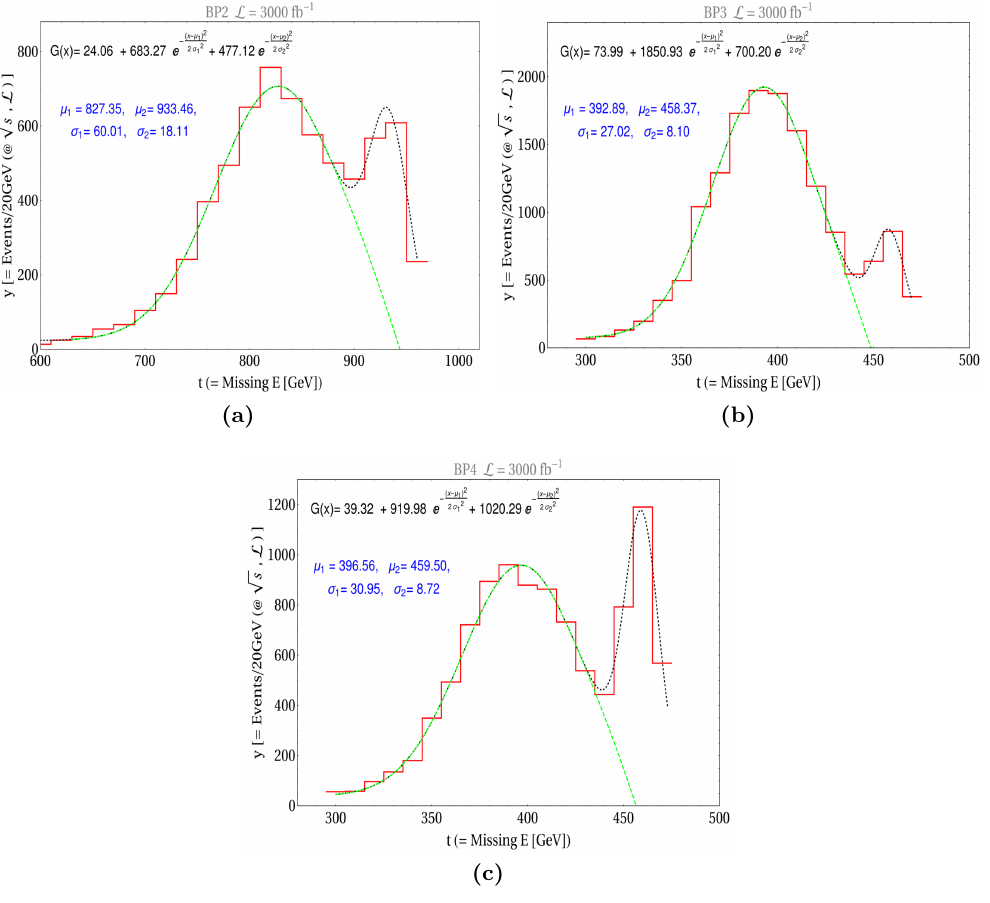
Figure 18. Same as figure 17 for BP2 (a), BP3 (b) and BP4 (c) at L = 3000 fb − 1